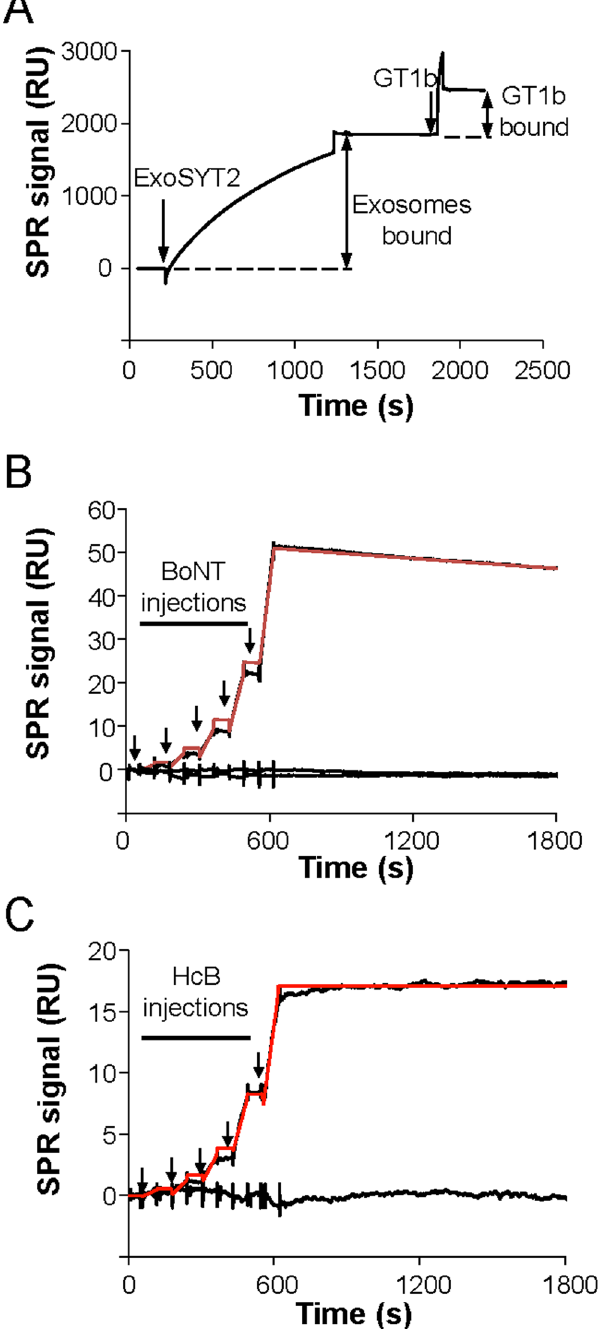
Figure 5. SPR measurements of BoNT/B and HcB affinity on immobilized exoSYT2/GT1b. ( A ) Functionalization of exoSYT2 flowcell: ExoSYT2 were injected into the flow-cell of a sensor chip with coupled anti-SYT mAb. Subsequent injection of GT1b (1 µ M) yielded an increase in RU illustrating online ganglioside insertion in exosomal membranes. ( B ) BoNT/B affinity determination: SPR analysis of the binding of BoNT/B holotoxin injected (arrows) in 2-fold dilutions from 1 to 16 nM to immobilized exoSYT2/GT1b and exoAMA1/ GT1b. Data obtained on exoAMA1 were automatically subtracted from exoSYT2 measurements and only specific data presented. The red trace corresponds to fitted data. The lower traces correspond to injection of BoNT/A and BoNT/E holotoxins to exoSYT2. ( C ) HcB affinity determination: As in ( B ) using HcB (arrows) instead of BoNT/B. Red trace corresponds to theoretical fitting. The lower trace corresponds to specific measurement of HcA binding to